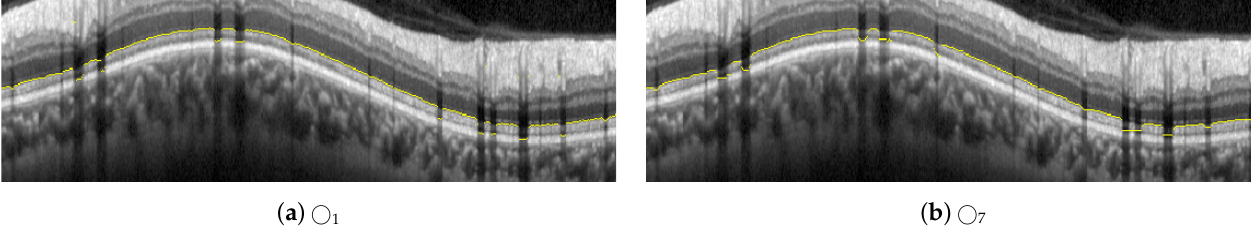
Figure 17. Results of changing the radius of the structuring element from (cid:13) 3 to (cid:13) 1 and (cid:13) 7 , used in the steps illustrated in Figure 8h–k for the delineation of #2-AB.